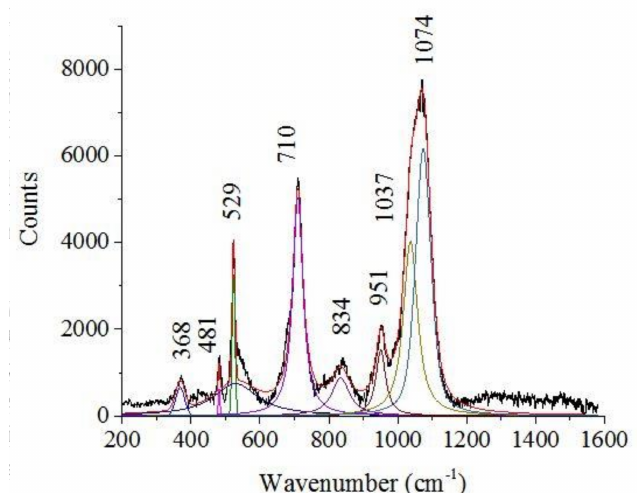
Figure 3. Raman spectrum of star-shaped boron carbide microcrystals synthesized from M-carborane at 7 GPa and 1370 K. The solid black line is the measured Raman spectrum, varicolored Gaussian shaped peaks are results of the Grams software